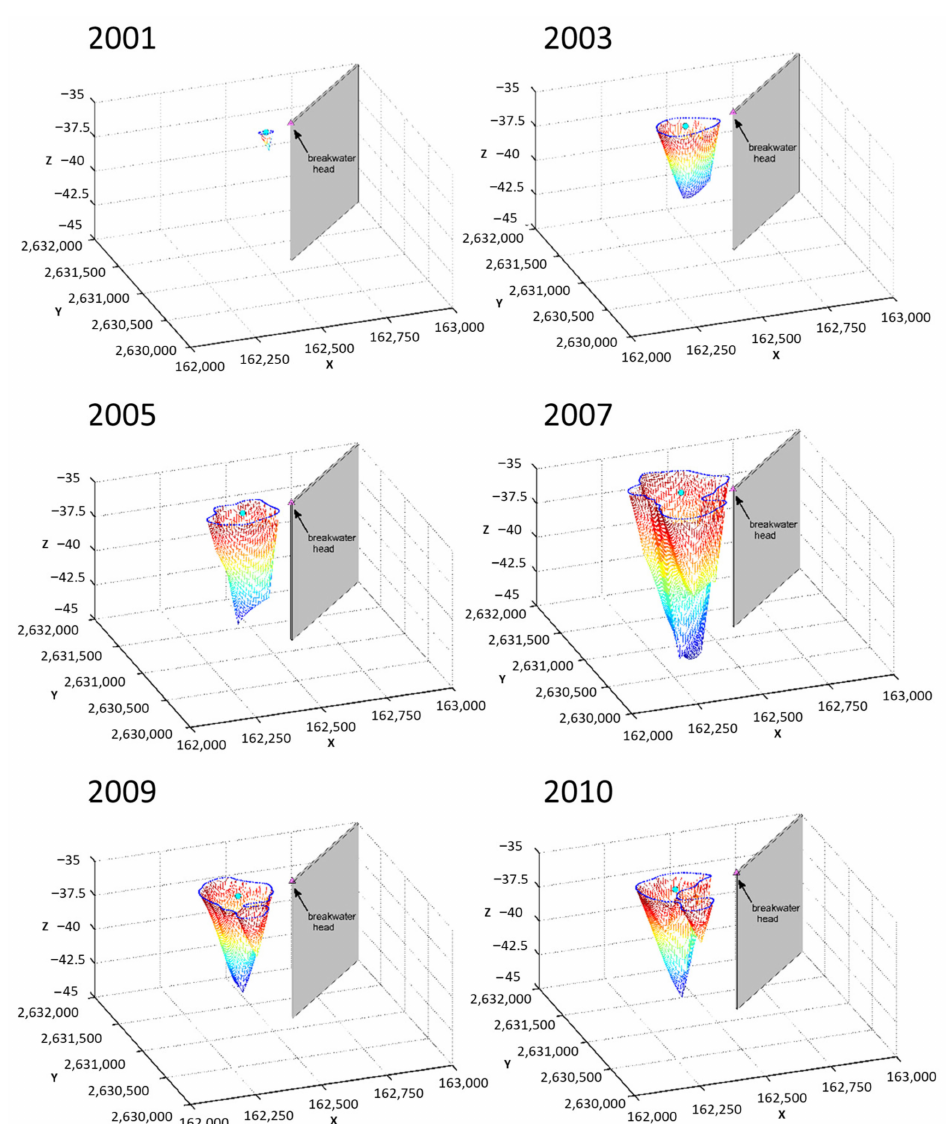
Figure 8. The development of the scour hole near the West